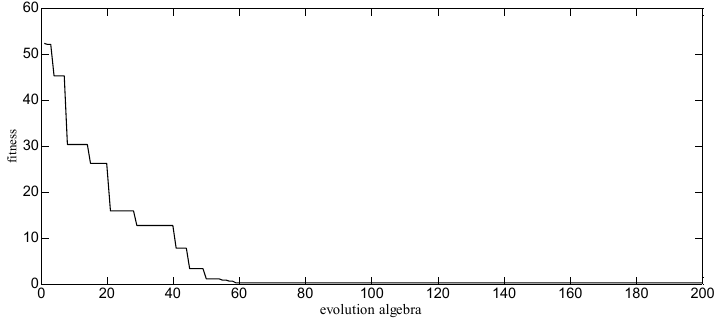
Figure 7. The curve of